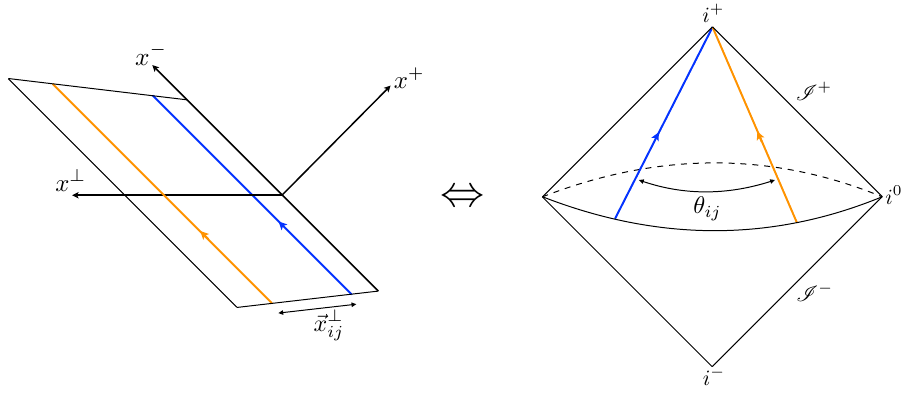
Figure 5 . Two light-ray operators (indicated by the blue and orange lines) on the null plane x + = 0 (left) can be mapped via the conformal transformation (7.7) to future null infinity I + (right). The transverse separation ~x ⊥ between the two operators on the plane leads to an angular separation θ ij ij on the celestial